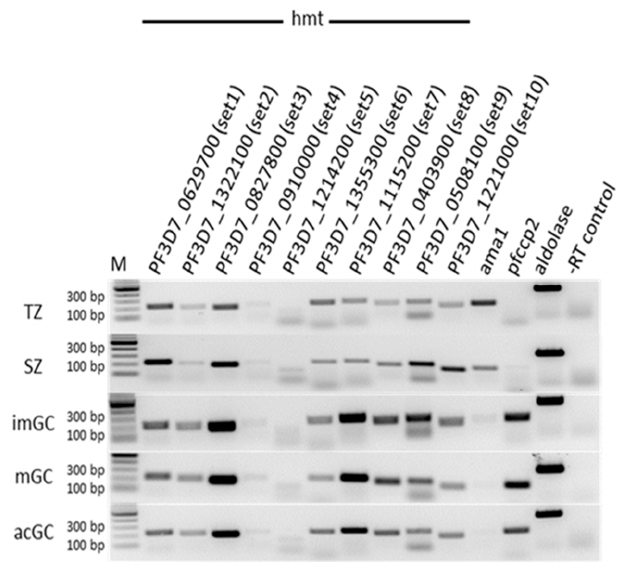
Figure 1. Transcript expression of the 10 SET ‐ domain containing proteins (HMTs) in P. falciparum . Complementary DNA prepared from trophozoites (TZ), schizonts (SZ), immature (imGC), mature (mGC) and gametocytes at 30 min post-activation (aGC) were subjected to RT-PCR using